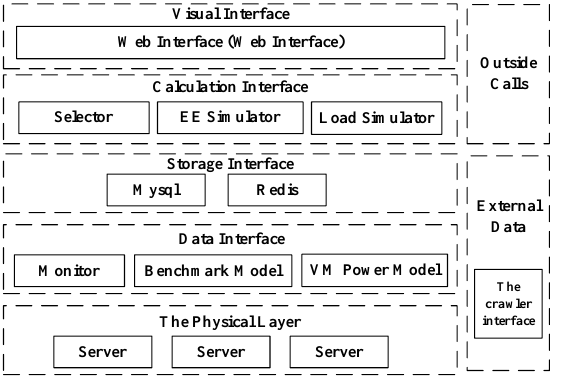
Figure 3. Escope